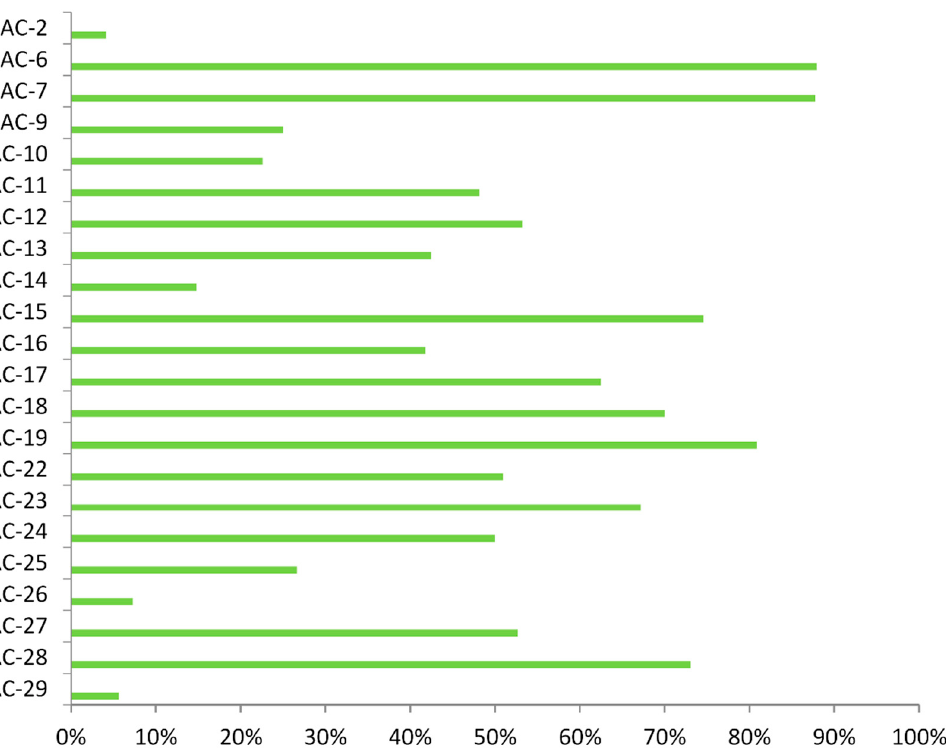
Figure 4. Percentage of samples of each rare IIF pattern with simultaneous presence of any common IIF pattern, determined using indirect immunofluorescence assay on HEp-2 cells in 1:100 dilution.